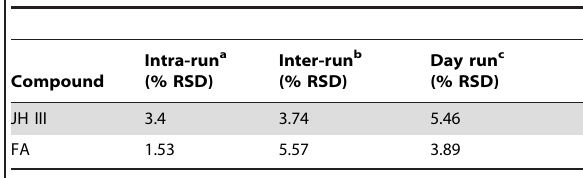
Table 1. Intra-run, inter-run and day run precision of JH III and FA quantification.